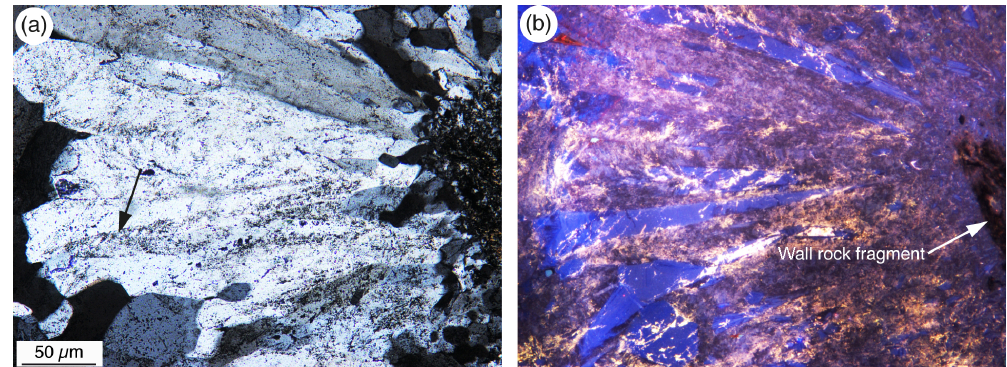
Figure 2. Photomicrographs of a quartz coating surrounding a wall rock fragment from the Rusey quartz zone: (a) X pol; (b) CL. (a) A wall rock fragment is surrounded by quartz, which increases in size from the fragment toward the left. The large comb quartz shows zones with densely distributed fluid inclusions (black arrow). (b) The CL image reveals that the comb quartz is made up by a core with partly euhedral faces. That core shows initial blue luminescence colors, a patchy area with violet luminescence is representing feathery textures, and yellow CL represents fluid inclusion trails (exposure time: 18.3s) (non-oriented sample TY39X2).